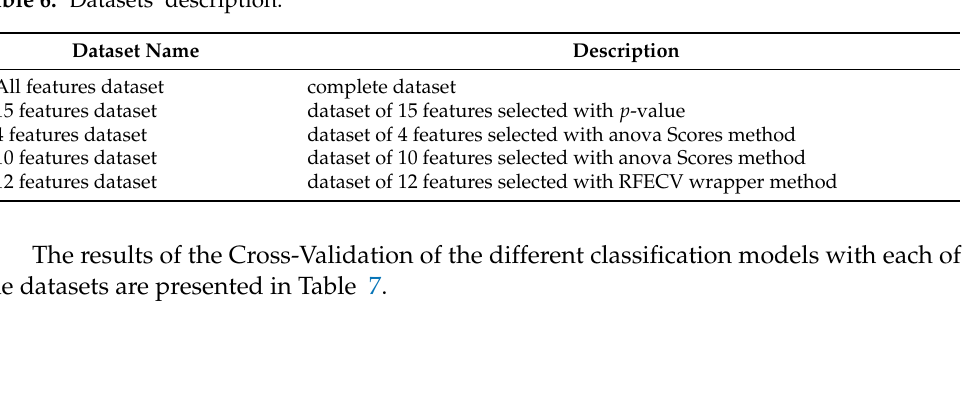
Table 6. Datasets’